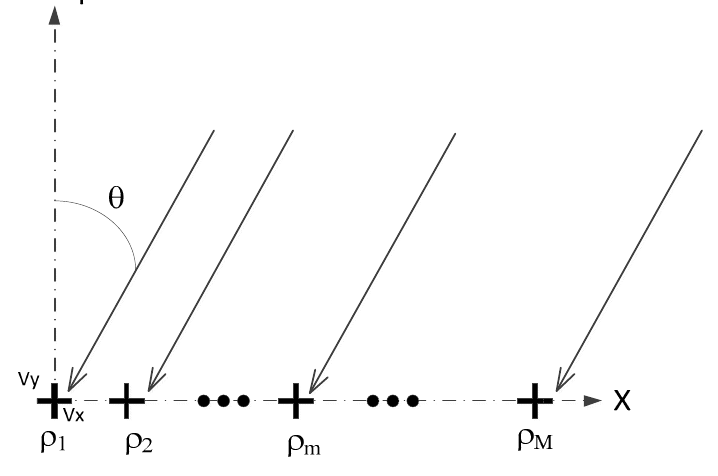
Figure 1. Vector hydrophone array model.